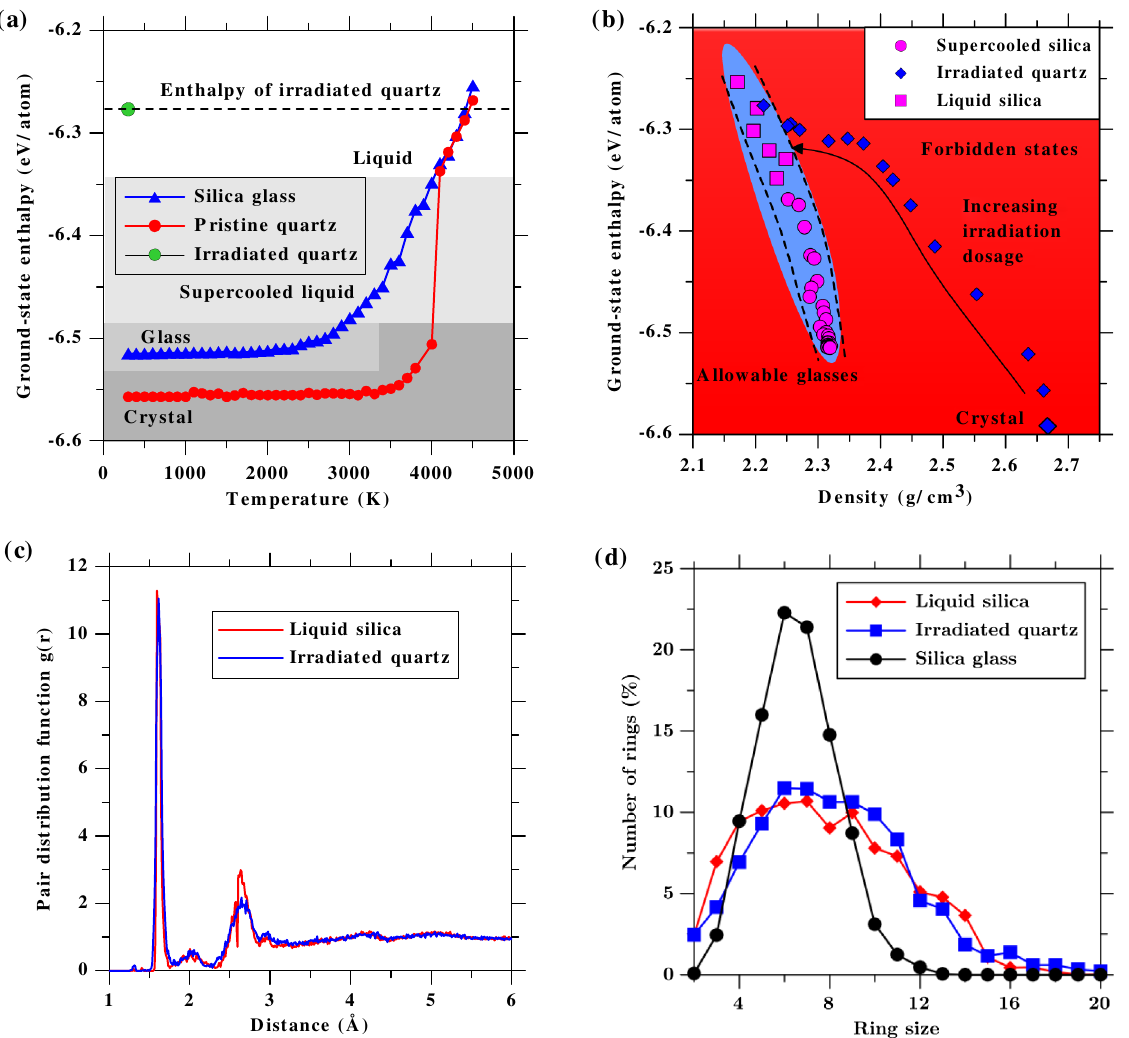
FIG. 3. Comparison of the effects of irradiation and temperature. (a) Ground-state enthalpy of pristine α -quartz and glassy silica as a function of temperature, compared with that of fully irradiated quartz at 300 K. The colored areas indicate the extent of the crystalline, glassy, supercooled liquid, and liquid states. (b) Positions of partially irradiated quartz samples in the ground-state enthalpy-density space, for increasing deposited energies. These data are compared to the ground-state enthalpy or density of α -quartz and liquid or supercooled silica at different temperatures. The light-blue and red background colors indicate the extent of the regions of allowable glasses and forbidden states, respectively. (c) Pair distribution function, g ð r Þ , of fully irradiated quartz, compared to that of a silica liquid hyperquenched from 4400 K. (d) Ring-size distribution of fully irradiated quartz, compared to that of a silica liquid hyperquenched from 4400 K and glassy silica. (For reference, the ground-state enthalpy of quartz with respect to the deposited energy is presented in Fig. S1 of Ref.